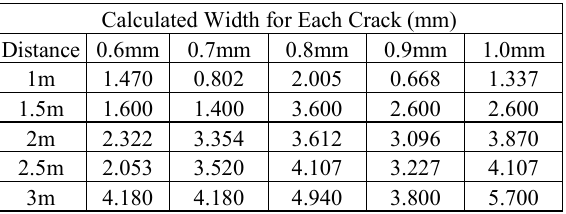
Table 10. The calculated widths.